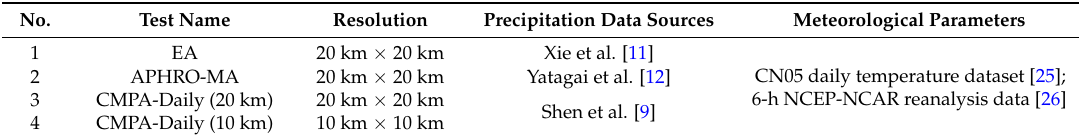
Table 1. Introduction to the experiment